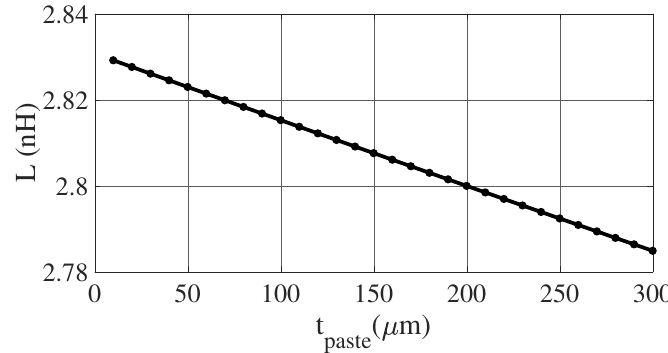
Figure 3. Influence of Cu thickness on its equivalent parasitic